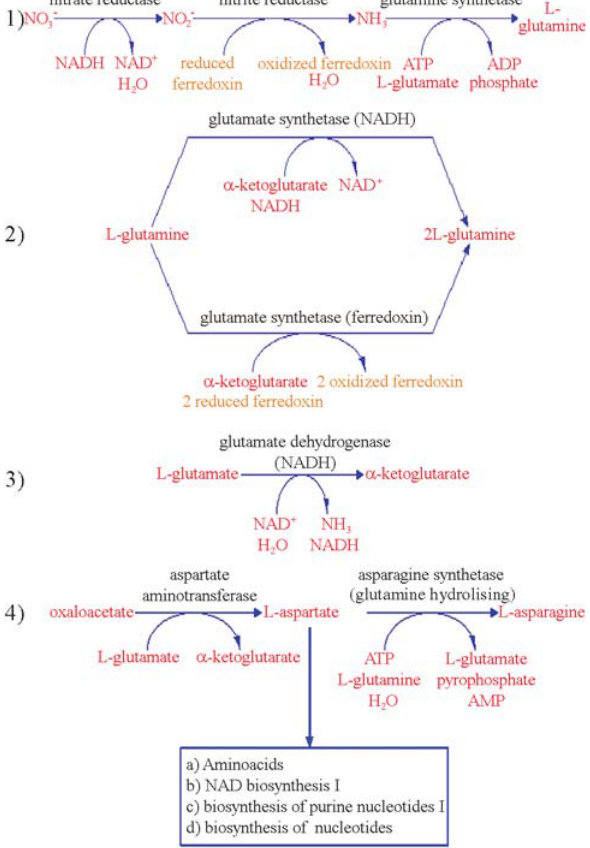
Figure 1 - The role of enzymes and metabolic pathways in nitrogen me- tabolism (AraCyc): A) Nitrate assimilation pathway and biosynthesis of glutamine; B) Ammonium assimilation cycle and biosynthesis of gluta- mate; C) Glutamate degradation; D) Biosynthesis of asparagine and biosynthesis and degradation of